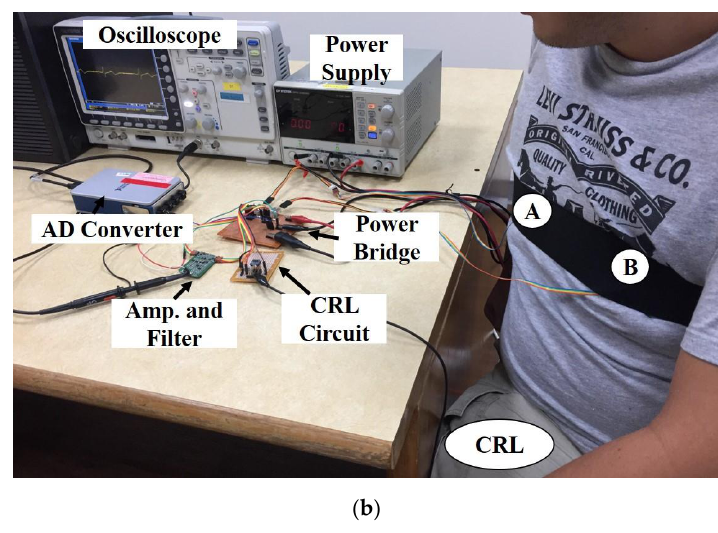
Figure 5. ( a ) Block diagram and ( b ) a photo of the presented CECG measurement apparatus.